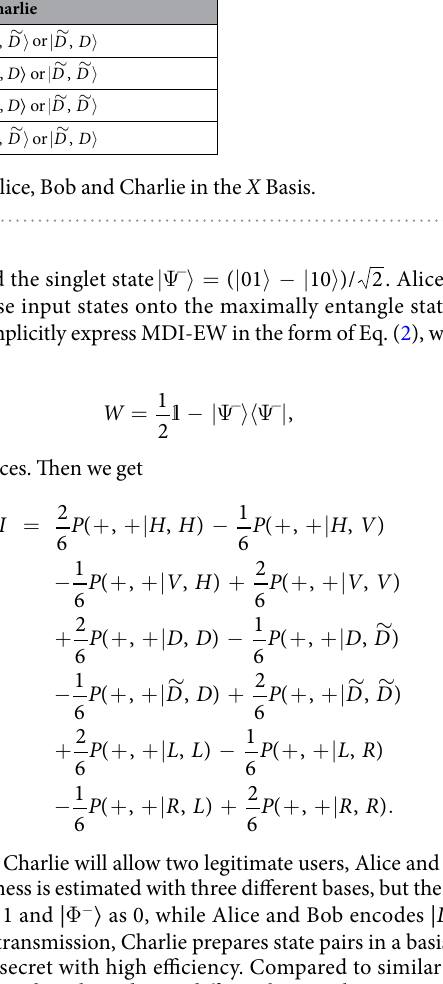
Alice Bob Charlie